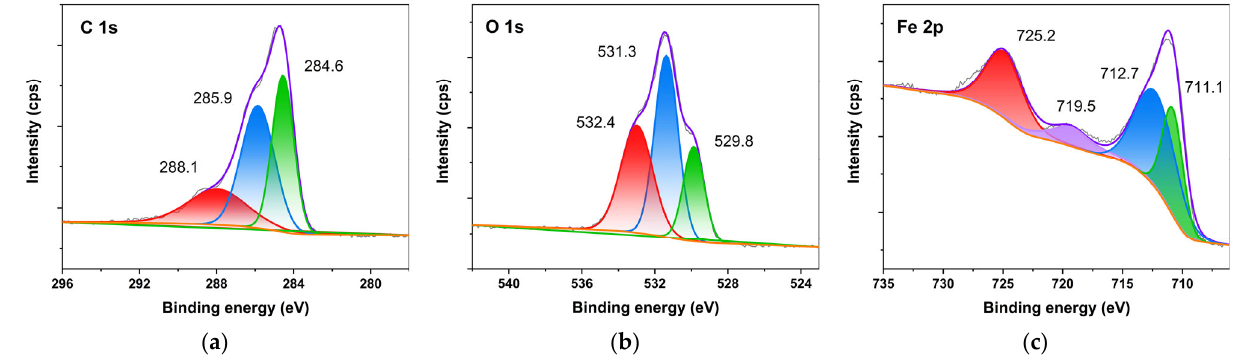
Figure 12. XPS spectra of rust in area B with proanthocyanidins. C 1s ( a ); O 1s ( b ); and Fe 2p ( c ).